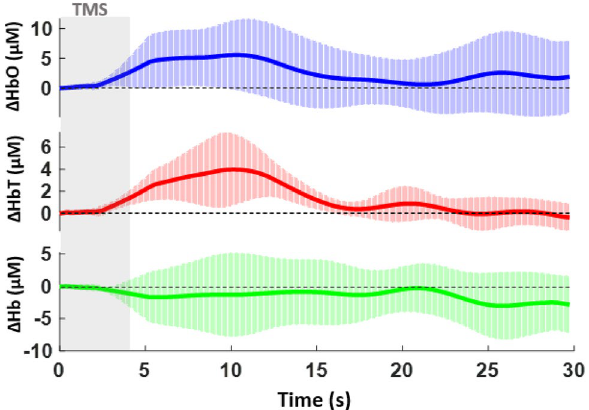
Figure 2. Averaged time course of oxygenated [HbO], total [HbT], and deoxygenated [Hb] hemoglobin signals in the healthy subjects for the contralateral or right dorsolateral prefrontal cortex. Ten hertz stimulation was performed for 4 s followed by 26 s of rest for a total of 12 epochs. The x-axis represents the time from 0 to 30 s during the epoch and the y-axis represents the mean and standard deviation for relative hemoglobin concentration in µM/L.